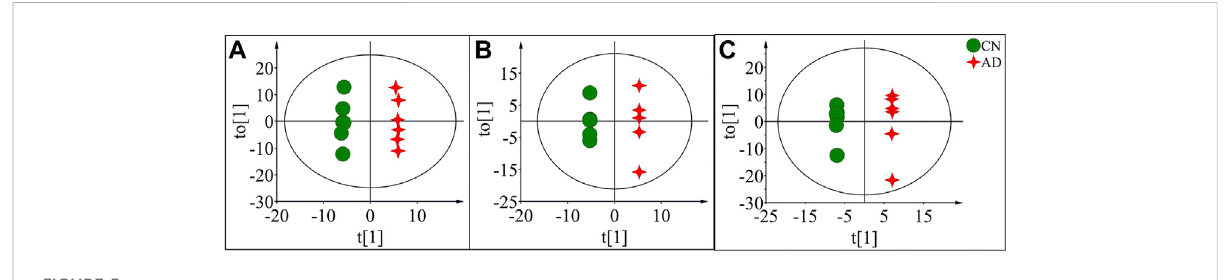
FIGURE 5 OPLS-DAscoreplotsofpotentialbiomarkersinthecontrolgroup(CN)andADmodelgroup(AD)inpositivemodeofLC-QTOF/MS (A) ,negative mode of LC-QTOF/MS (B) , and in GC-MS (C)